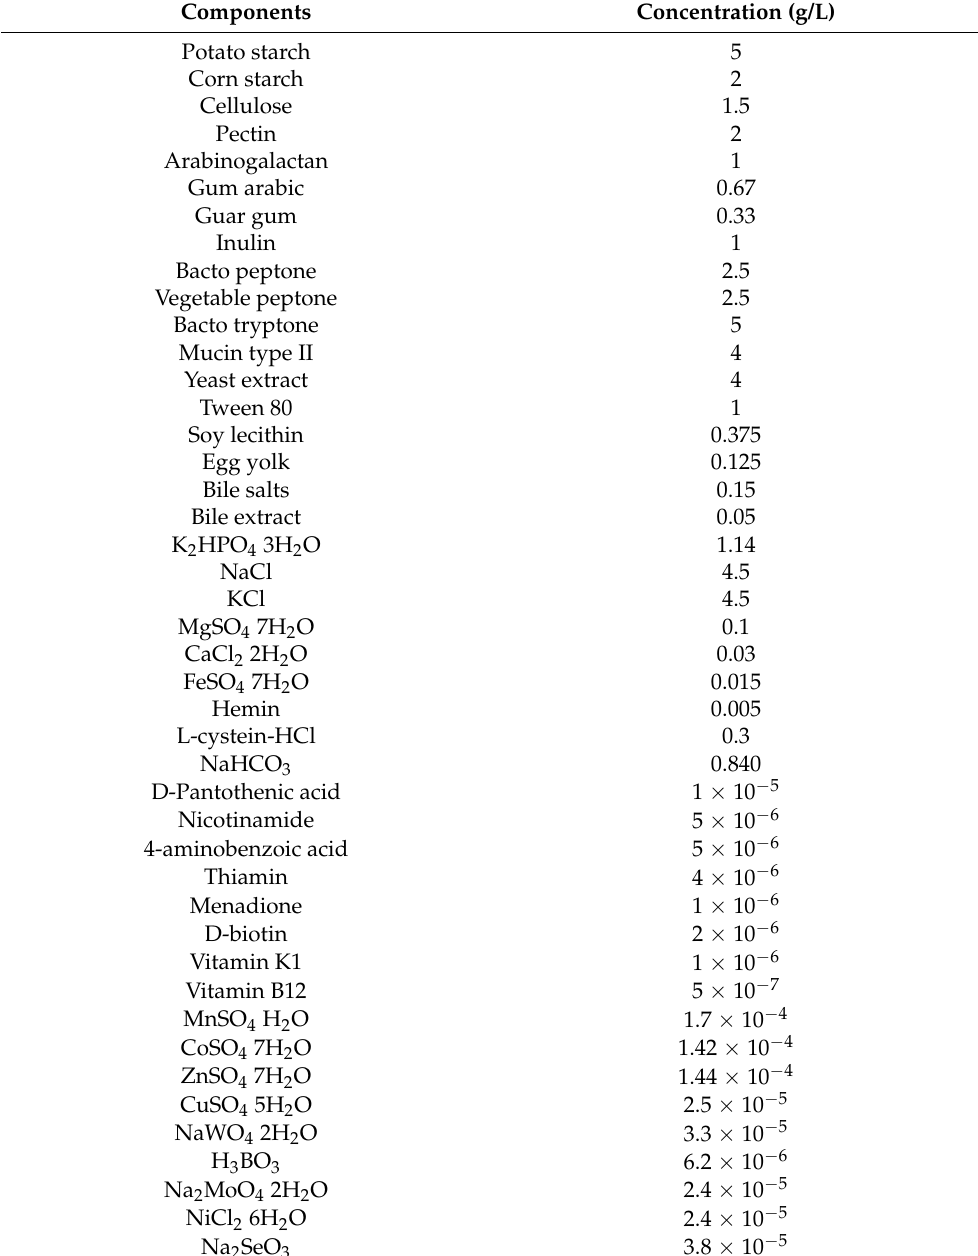
Table 1. Composition of the nutritive medium used to feed in vitro ARtificial COLon (ARCOL) system and simulating the composition of human ileal